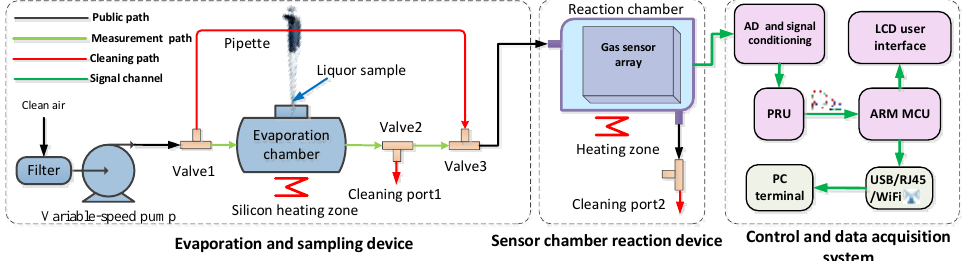
Figure 5. Structure of the designed e-nose system for Chinese liquors recognition.